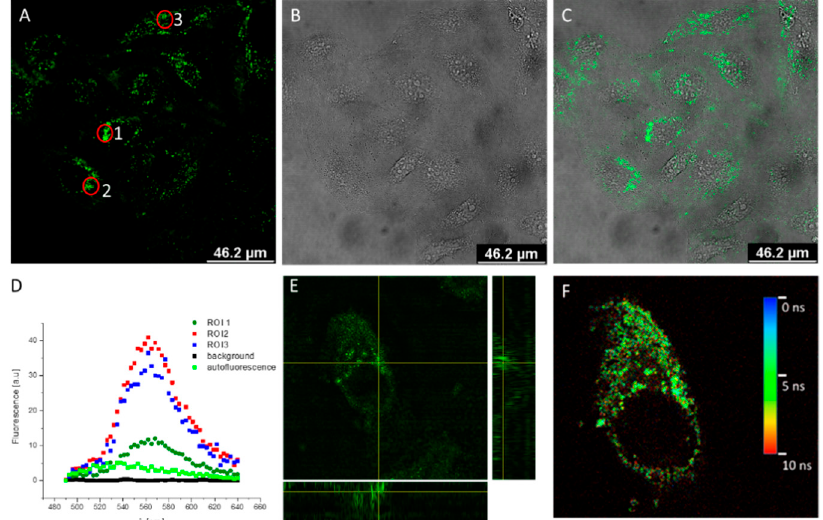
Figure 1. QD:Puf nanohybrids visualized inside HeLa cells after 24 h of incubation. CLSM images ( A ) fluorescence emission (excitation 450 nm, emission 550–650 nm), ( B ) bright-field and ( C ) image overlay. ( D ) emission spectra recorded for ROIs marked as the red circle in the image ( A ), back- ground and control emission detected in untreated, control cells. ( E ) orthoslices of Z-stack recorded for individual treated cells. Z-stack were deconvolved and particular original Z-stack images are provided in Supplementary Materials, Figure S5. ( F ) FLIM image recorded for individual treated cells using 450 nm laser line and 550–650 nm emission range. The color scale represents individual pixel lifetime. The growth medium contained 10 nM of